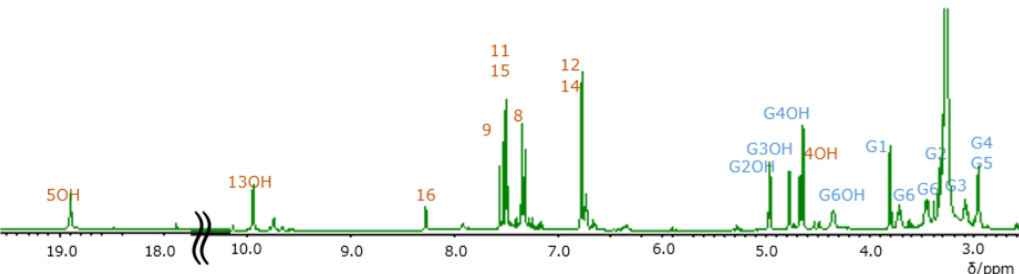
Figure 3. Assigned 1 H NMR spectrum of carthamin potassium salt recorded in DMSO- d 6 at 30 °C.